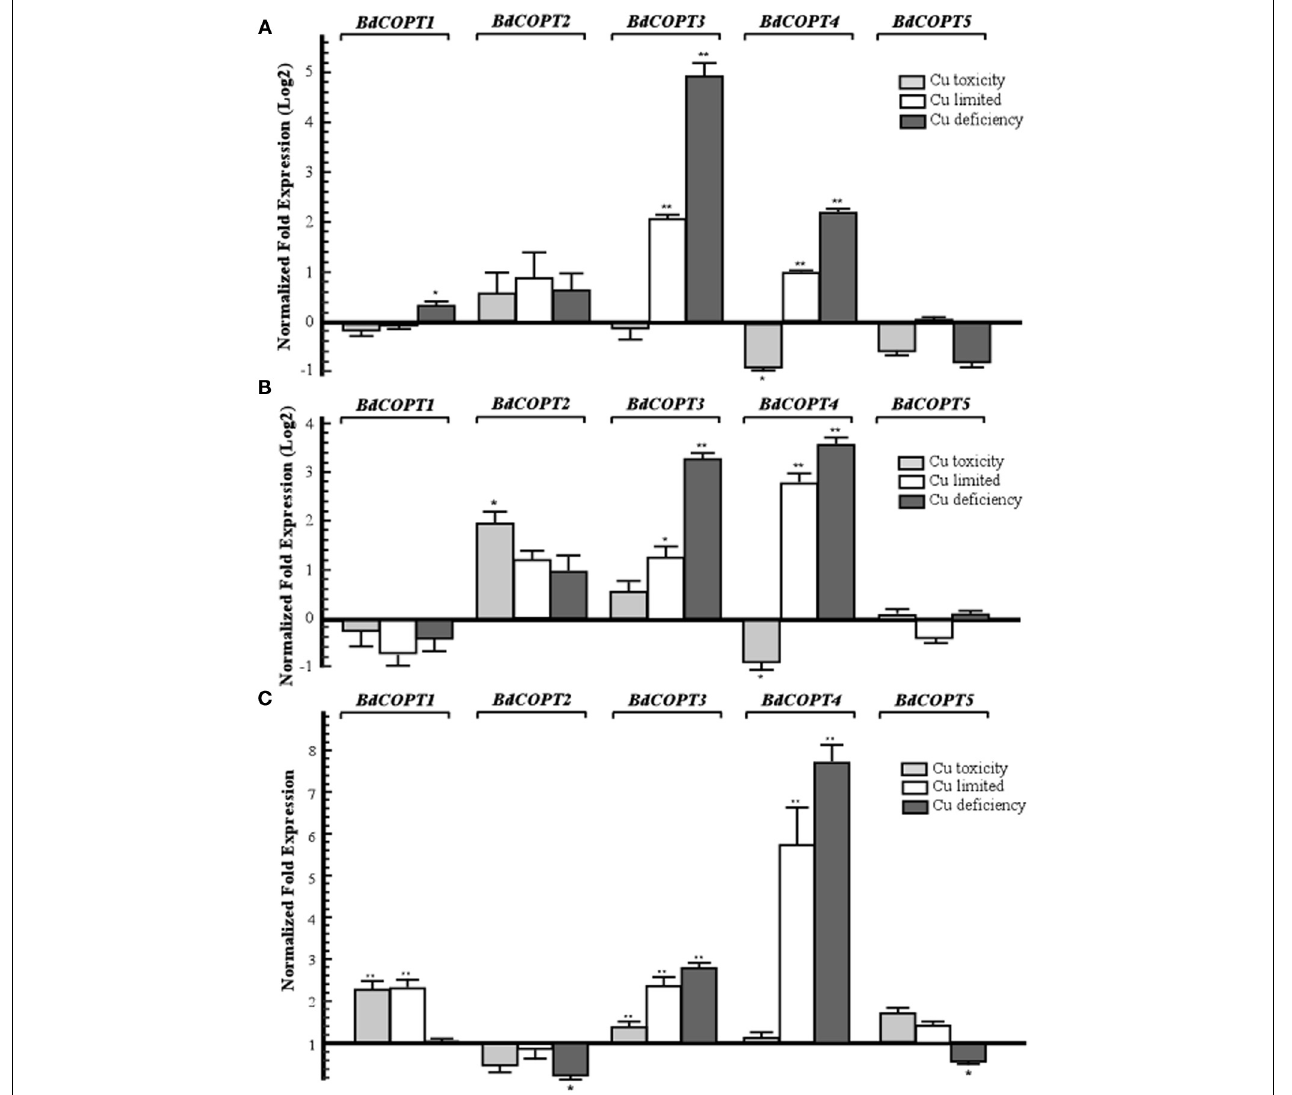
FIGURE 3 | Quantitative real-time (qRT)-PCR analysis of the effect of Cu on expression COPT1 through 5 in roots (A), young leaves (B), and older leaves (C) of brachypodium. For all treatments, 7-day-old wild-type seedlings were transferred to hydroponic solution and were grown for 18 days in medium that, in addition to macro- and micronutrients, contained